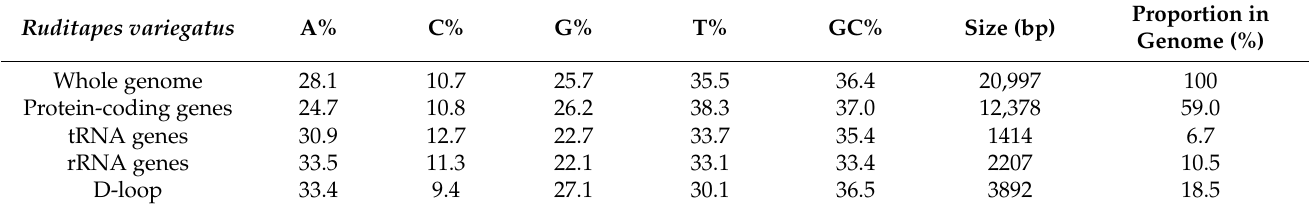
Table 6. Genomic features of Ruditapes variegatus .